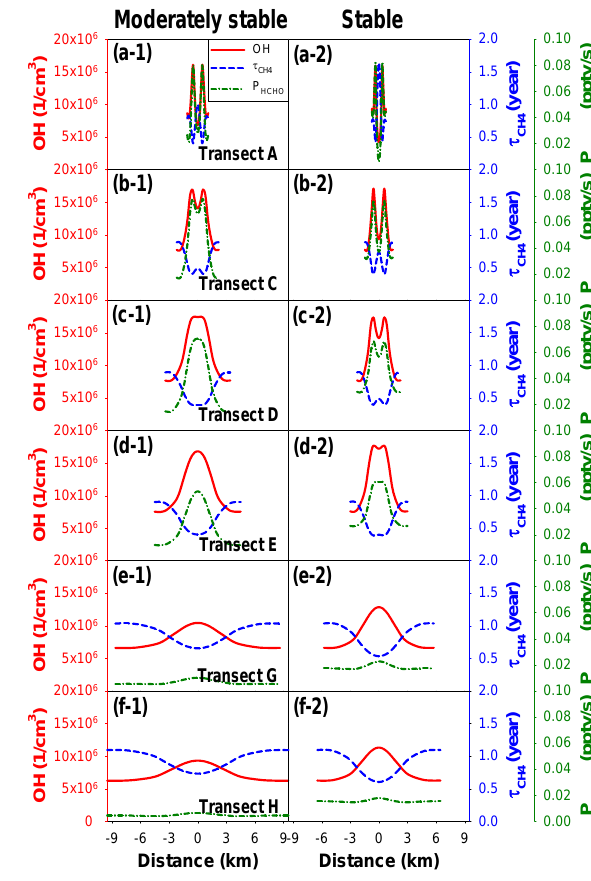
Fig. 6. Profiles of OH radical concentrations (red-solid lines), in- stantaneous chemical lifetime of CH 4 ( τ CH , blue-dashed lines), 4 and net instantaneous HCHO production rate ( P HCHO , green-dotted lines) at six ship-plume transects under moderately stable and stable MBL